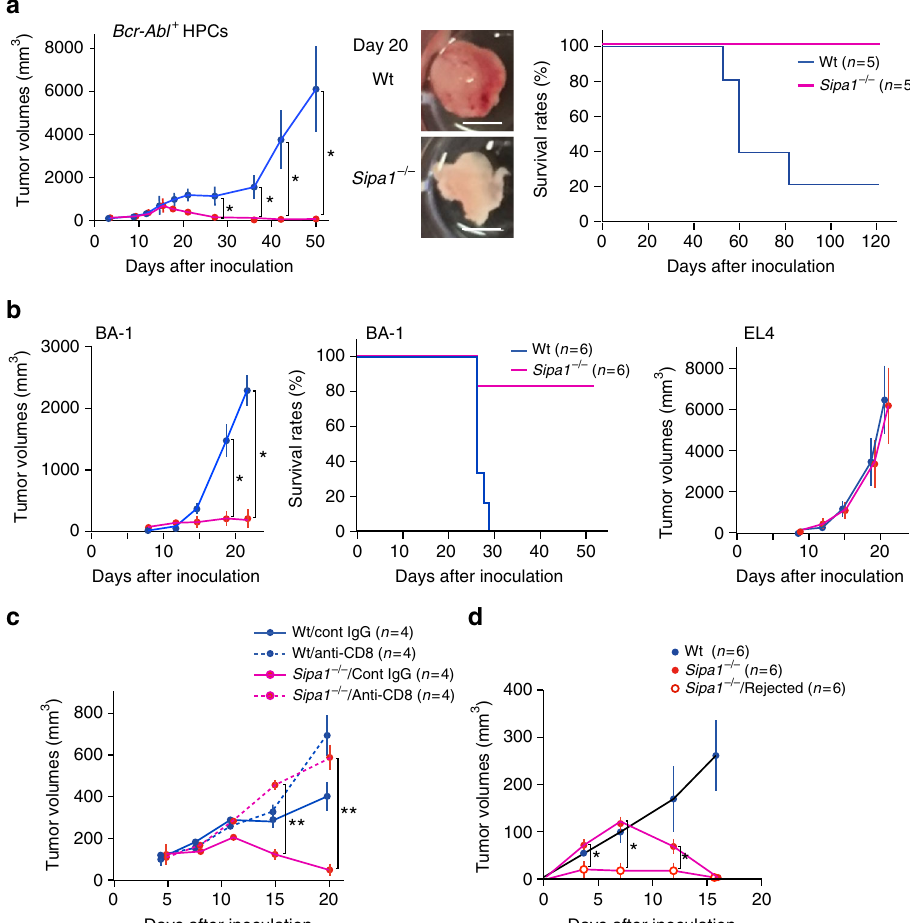
Fig. 5 Sipa1 − / − mice reject the subcutaneous tumors by Bcr-Abl + HPCs in a T-cell-dependent manner and develop immune memory. a Bcr-Abl + HPCs in Matrigel matrix were injected subcutaneously into Wt and Sipa1 − / − mice at 1.5 × 10 4 cells per mouse, and the tumor volumes in the local sites were measured. The means and SEs of tumor volumes and survival curves of fi ve mice per group are shown. * p < 0.05 (two-tailed unpaired Student ’ s t -test). The experiments were done at least three times with similar results. Representative pictures of tumor masses on day 20 are also indicated. Scale bars, 5 mm. The white mass in Sipa1 − / − mice represents residual Matrigel matrix. b BA-1 or EL4 leukemia cells were subcutaneously injected into Wt and Sipa1 − / − mice, and the tumor volumes were measured. The means and SEs of tumor volumes and survival curves of six mice per group are shown. * p < 0.05 (two- tailed unpaired Student ’ s t -test). The experiments were performed four times. c Wt and Sipa1 − / − mice were injected with anti-CD8 antibody or isotype- matched IgG, followed by subcutaneous challenge with Bcr-Abl + HPCs. The means and SEs of tumor volumes of four mice per group are shown. ** p < 0.01 (two-tailed unpaired Student ’ s t -test). The experiments were done twice. d Sipa1 − / − mice were subcutaneously injected with Bcr-Abl + HPCs on one side of frank. Thirty days later, when the tumors were completely rejected, these mice were rechallenged with Bcr-Abl + HPCs on the other side of frank. Untreated Wt and Sipa1 − / − mice served as unimmunized controls. The means and SEs of tumor volumes of six mice per group are shown. * p < 0.05 (two-tailed unpaired Student ’ s t